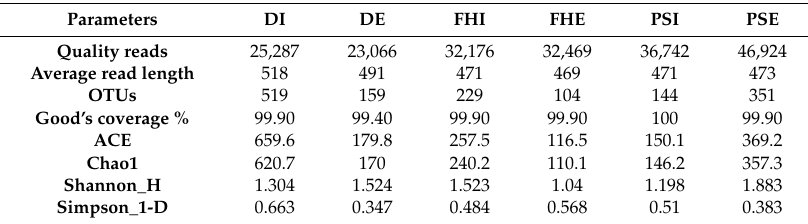
Table 2. Summary for the bacterial richness and diversity of microbial communities for the WWTPs.